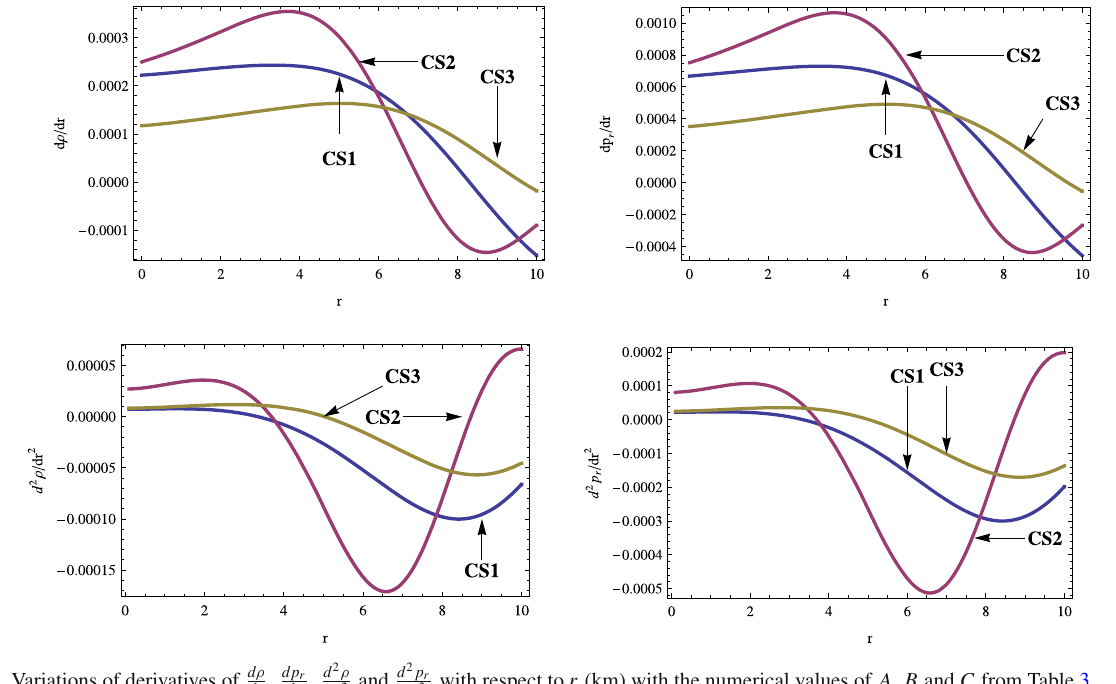
, dp r , d 2 ρ and d 2 p r with respect to r (km) with the numerical values of A , B and C from Table 3 dr dr dr 2 dr 2